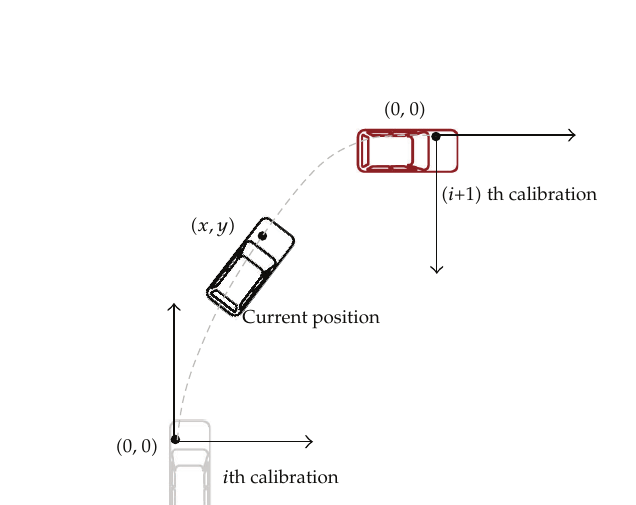
Figure 6: Example of f (cid:2) γ (cid:3) .